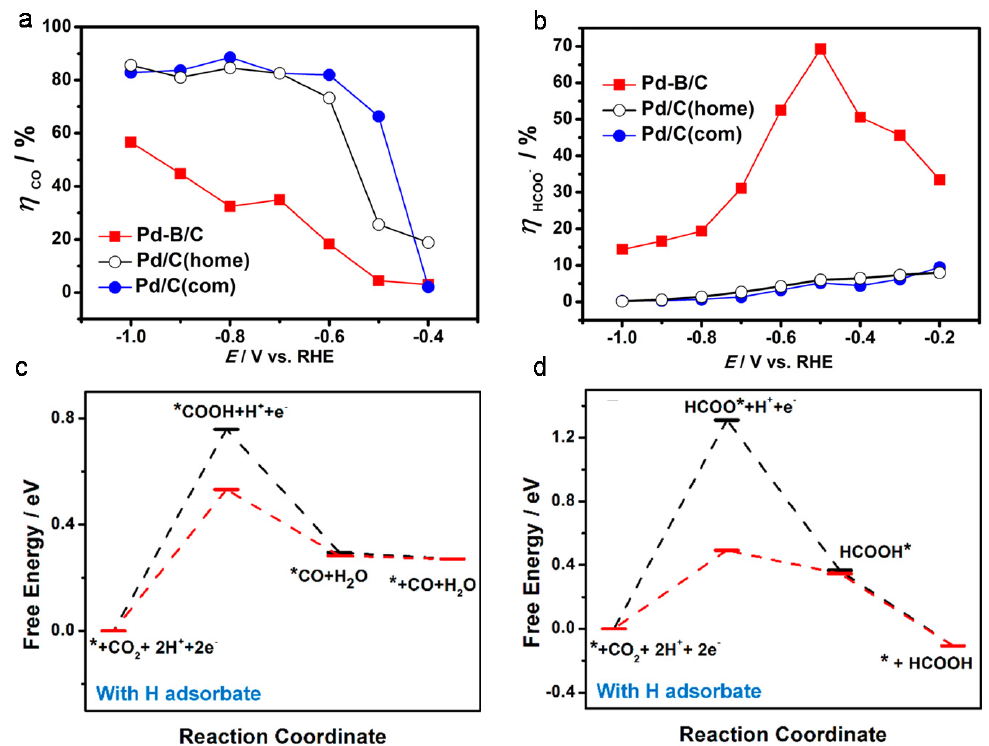
Figure 7. Potential-dependent FEs of: ( a ) CO and ( b ) formate; Gibbs free energy diagram for CO 2 RRs on Pd(111) (black) and Pd(111) − 4B (red) for the ( c ) CO pathway and ( d ) HCOOH pathway [72]. Copyright 2018, ACS.